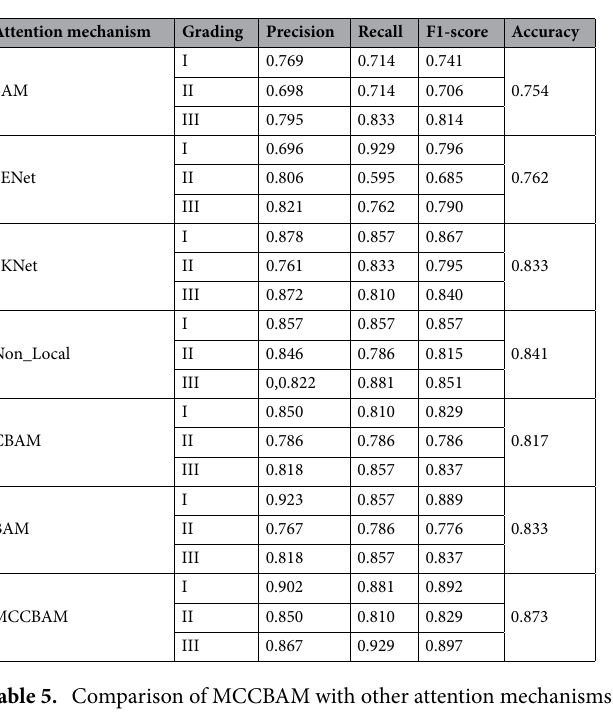
cancer. Figure 6a,b shows the accuracy and AUC values of different models for grading histopathological images, respectively. (See Supplementary Material for the confusion matrix). Grad-CAM visual analysis. Grad_CAM is a widely used method for visualizing feature maps that uses gradients to calculate the importance of spatial locations in a convolutional layer 46 . In the heat map generated by Grad_CAM, the blue color is the unimportant region, while the red color is the critical region associated with that category. The classifier makes judgments based on these local pixel-level features in red. As shown in Fig. 7, the upper part is the histopathological image of colorectal cancer stained by H&E, and the lower part is the Grad- CAMs generated by HCCANet after extracting relevant features. Figure 7a–c shows the images of colorectal cancer at grade I, grade II, and grade III stages (i.e., highly differentiated, moderately differentiated, and poorly differentiated stages, respectively), Fig. 7(a1), (b1) and (c1) are their corresponding Grad-CAMs.